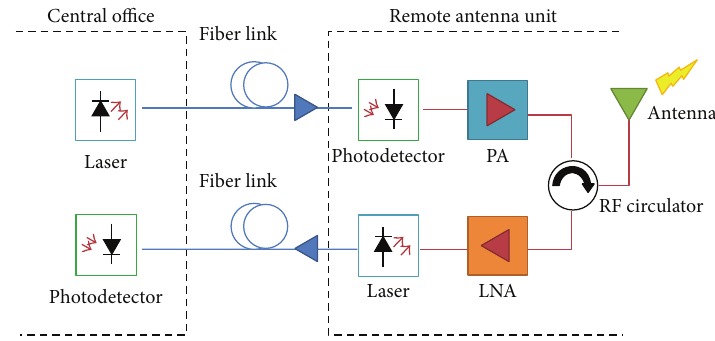
Figure 1: RoF system block